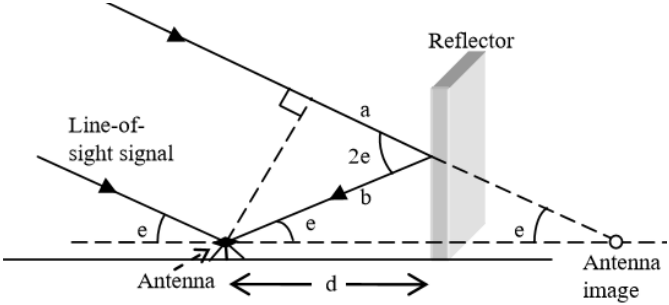
Figure 1. Geometry of multipath signals, a reflector, and an antenna (adapted from [13]). Multipath errors can be mitigated using stochastic models based on Carrier-to-Noise Ratio (CNR) or Signal-to-Noise Ratio (SNR) [13,14]. Simple stochastic models are based on the satellite elevation angle (E) [13,15]. For example, assuming the variance of the carrier phase error to be: σ 2 = 1/sin 2 𝐸 .